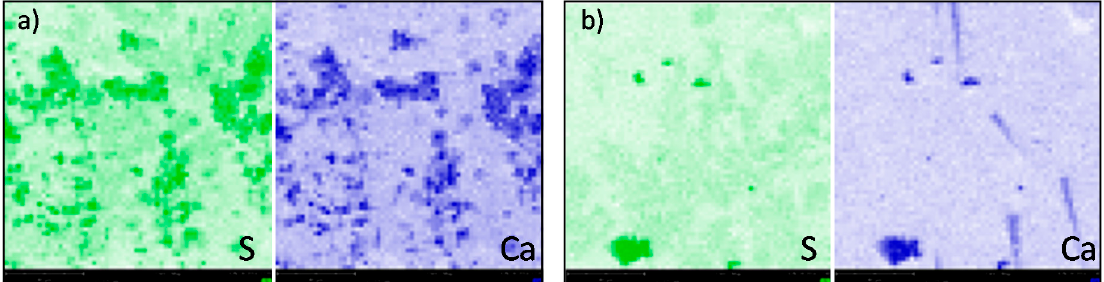
Figure 3. Sulfur ( green ) and calcium ( blue ) distribution maps at two locations (( a ): 0.1 cm and ( b ): 0.5 cm from inlet) along a central channel of the 18 kh reaction-aged SCR honeycomb catalyst.